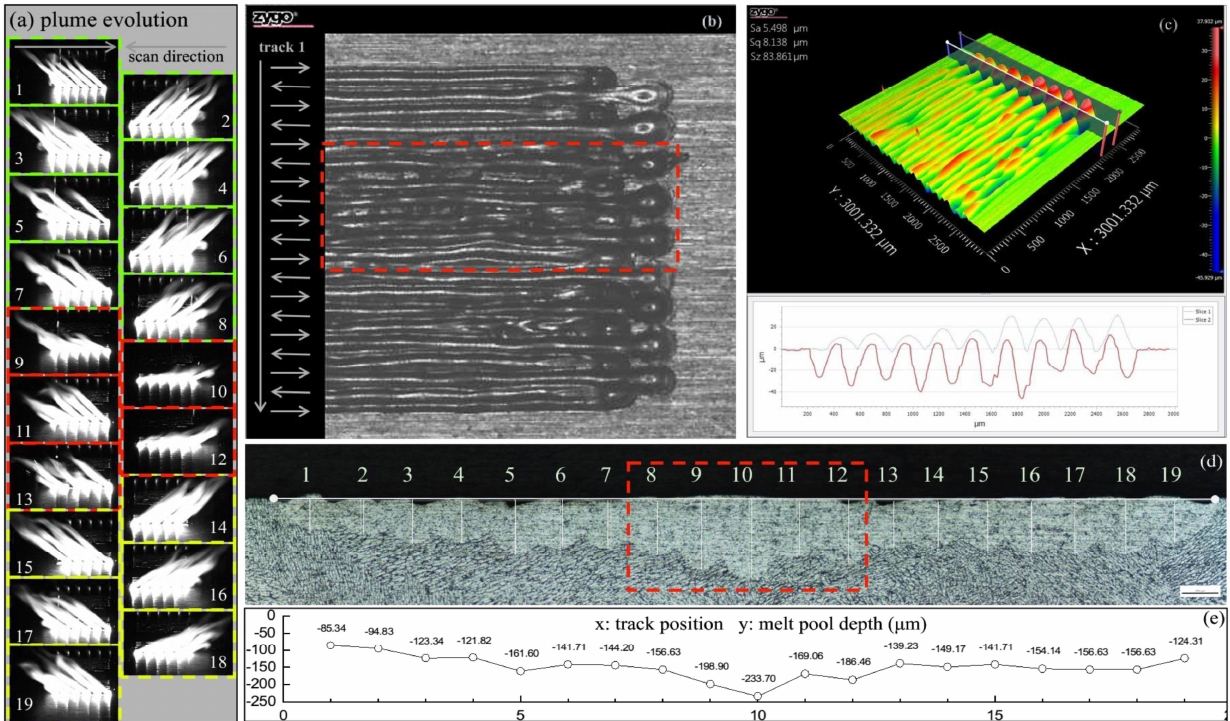
Figure 9. Correlation of plume behavior and melting quality in multi-track laser scanning at 500 W–1000 mm/s. ( a ) Track-by- track superimposed images of plume evolution, the vertical plumes at the starting stages of each track are omitted for better clarity; the arrow indicates laser direction of the column and the track number are placed next to the track start. ( b ) Surface quality of the scanned layer. The gray arrows indicate scan direction and track succession, while the dashed line shows where the sample was sectioned. ( c ) 3D height map of surface quality. ( d ) Cross section evolution. ( e ) Penetration